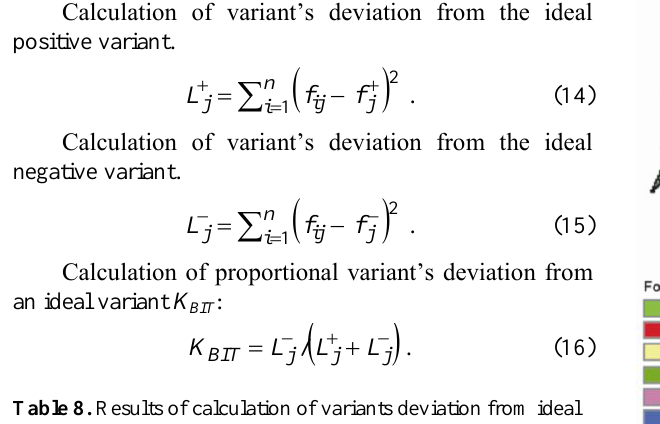
Table 8. Results of calculation of variants deviation from ideal positive and ideal negative variants as well as K BIT values Variable Fig. 5. Spatial distribution of Lithuanian forest fragmentation components at 65.61 ha blocks. Administrative boundaries of state forest enterprises are shown as reference